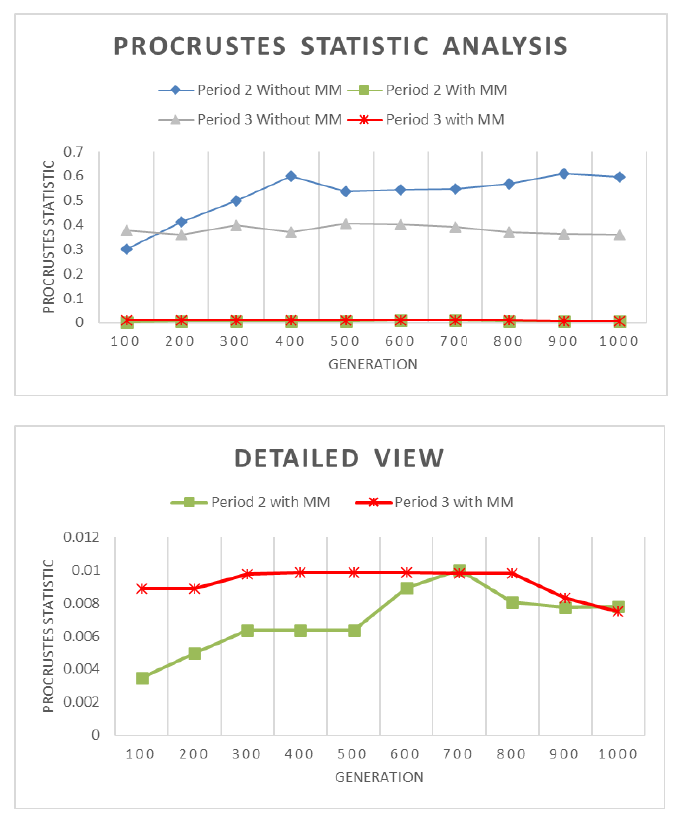
Figure 12. Procrustes analysis results.